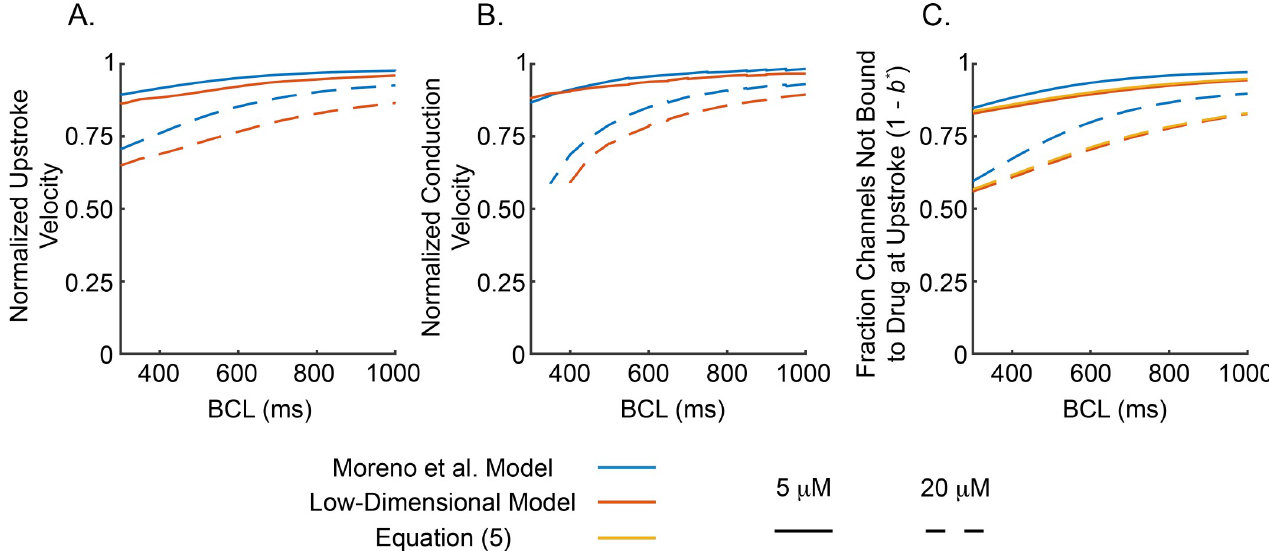
Fig 4. Rate-Dependent Effects of Lidocaine. Normalized peak upstroke velocity (A), conduction velocity (B), and fraction of channels not bound to drug during the upstroke (C) plotted against BCL for the ten Tusscher et al. human ventricular myocyte model [22,23] with the Moreno et al. model (blue curves) or low-dimensional model (orange curves) of the Na + conductance. Peak upstroke and conduction velocities for 5 μM (solid curves) and 20 μM (dashed curves) concentrations of lidocaine are normalized by peak upstroke and conduction velocities at the same BCL in the corresponding drug-free model. In C, predictions from an analytically derived expression for fraction of channels bound to drug during the upstroke ( b � ) in our low-dimensional model are also plotted (yellow curves; see Eq (5)) and were shifted up slightly to make them visible as they overlap the output of the ten Tusscher et al. model with our low- dimensional Na + conductance